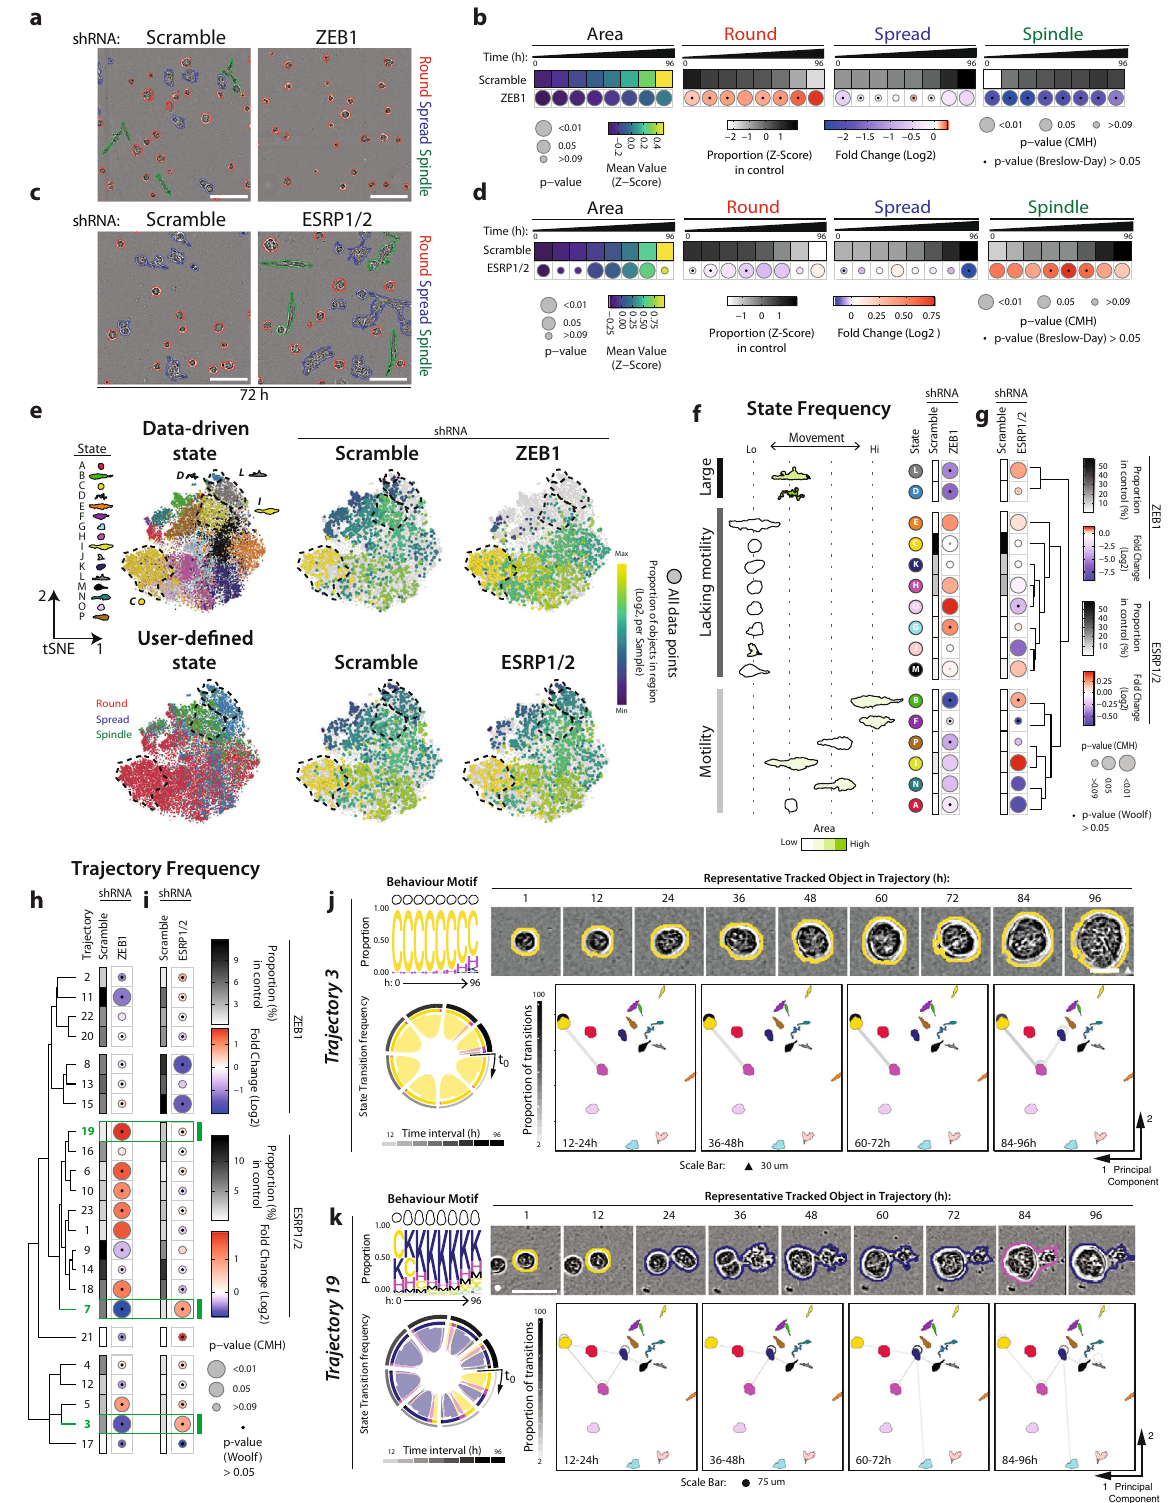
user-de fi ned states (Round, Spread, Spindle) (Supplementary Fig.16a), with and without HGF treatment. Total ZEB1 expression, as well as the ratio of nuclear:cytoplasmic localisation, was modestly higher in spheroids displaying Spindle shape in comparison to Round and Spread spheroids both at steady state and upon HGF treatment (SupplementaryFig.16b,c).Notably,theadditionofHGFonlycauseda modest alteration to ZEB1 total expression and a modest but